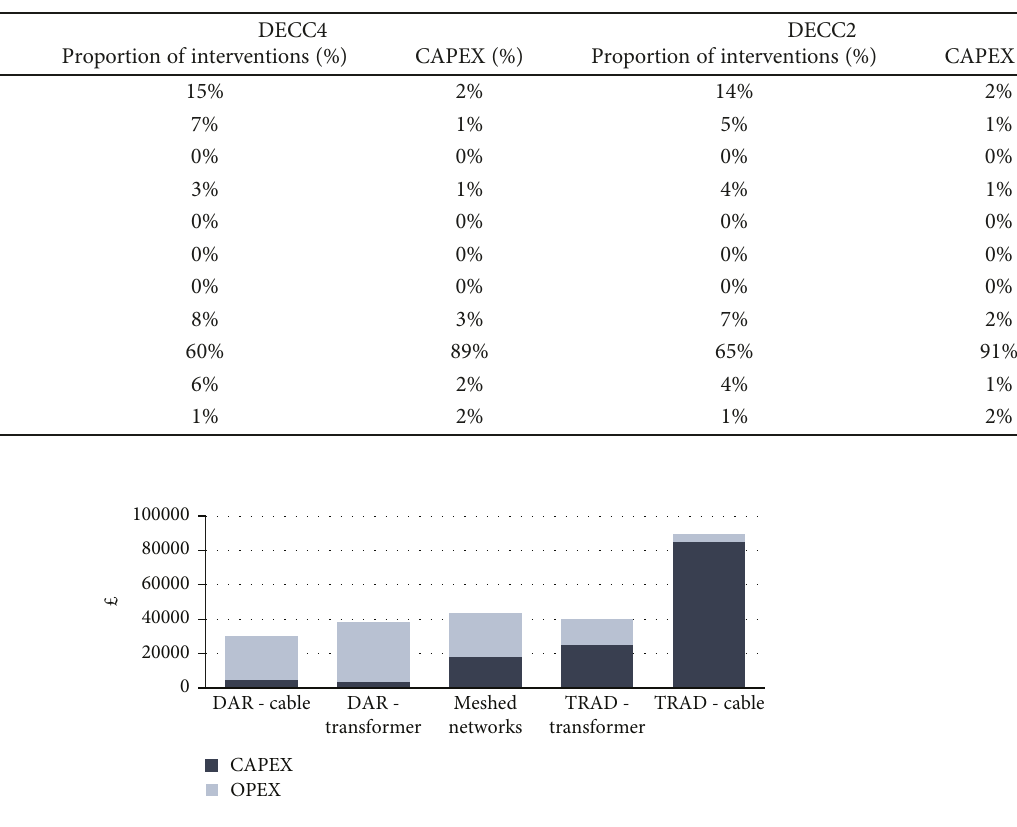
Table 2: Number of interventions and CAPEX involved; DECC4 and DECC2, 2015 – 2023.